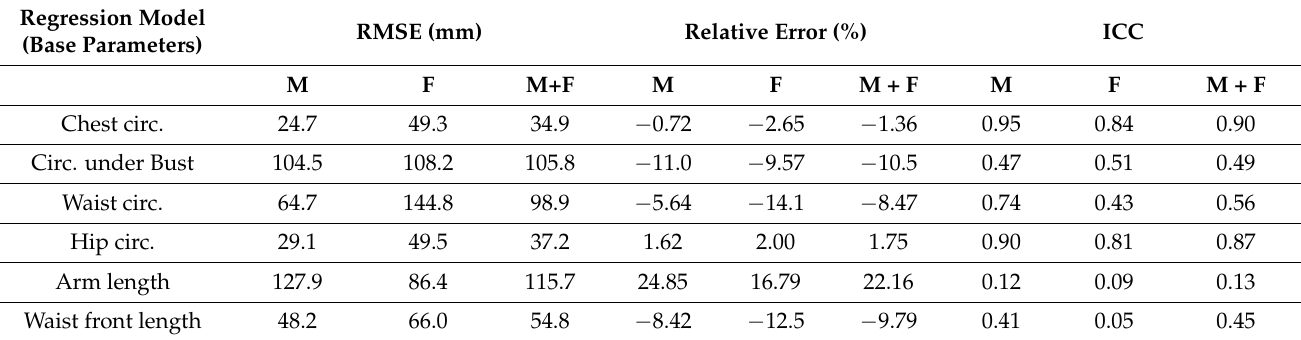
Table 2. Overview of results on the regression model prediction based on the base parameter inputs.